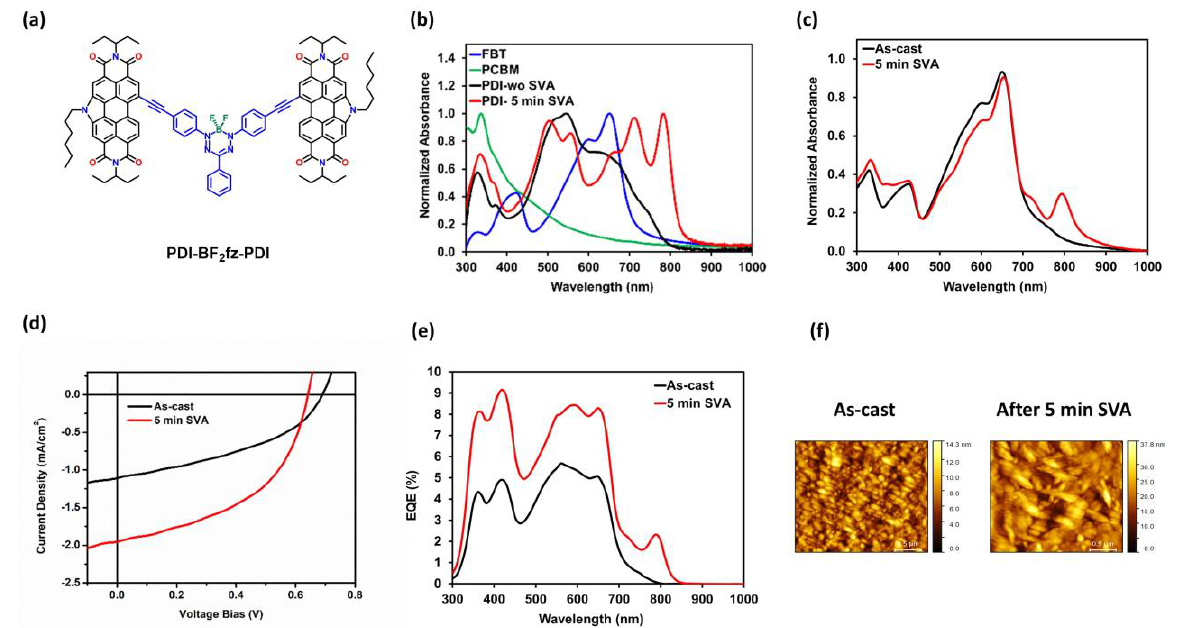
Figure 7. ( a ) Chemical structures of the PDI-BF 2 fz-PDI acceptor, ( b ) UV–Vis absorption spectra of neat films before and after chloroform SVA, ( c ) UV–Vis absorption spectra, ( d ) device J–V curves, ( e ) device EQE, and ( f ) AFM iamges comparing the effects of SVA using chloroform on ternary blend OPV devices with FBT:PDI-BF 2 -PDI:PC 61 BM (1:1:0.5) active layers [88]. ( b – f ) reproduced with permission from [88]. Copyright 2020 Royal Society of Chemistry.